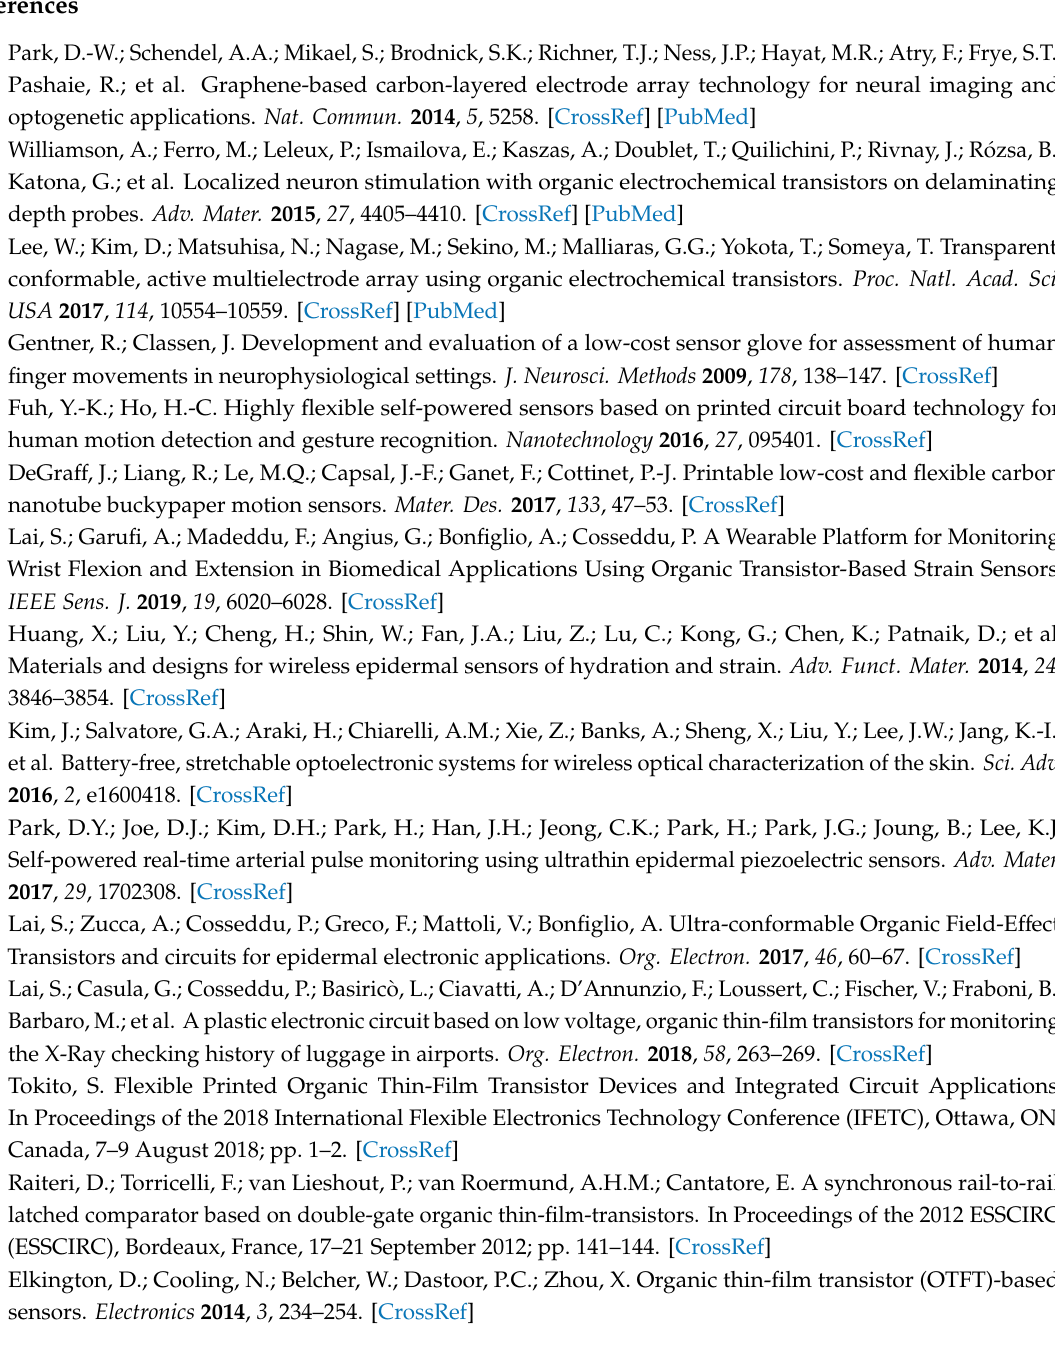
Pictures showing the successful transfer of ultra-conformable OFETs to human skin. Figure S3: Absorbance for bare PET (black), OFETs fabricated on PET without (red) and with (blue) TIPS pentacene, and for ultra-conformable devices on Parylene C films (magenta). These data correspond with those on transmittance reported in Figure 5 of main